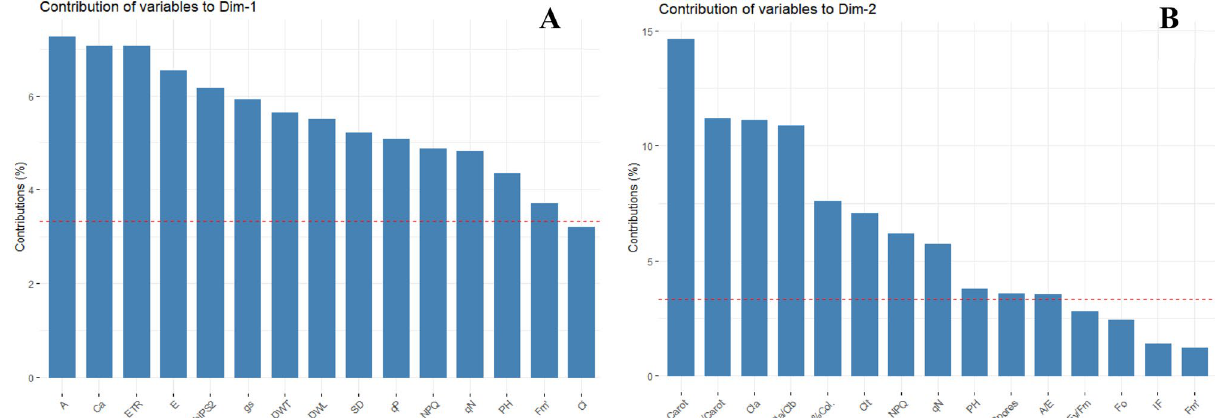
Figure 7. Contributions of variables in corn plants (Zea mays) submitted to different water treatments and inoculated with AMF after reirrigation. First dimension ( A ) and second dimension ( B ). A, Photosynthetic